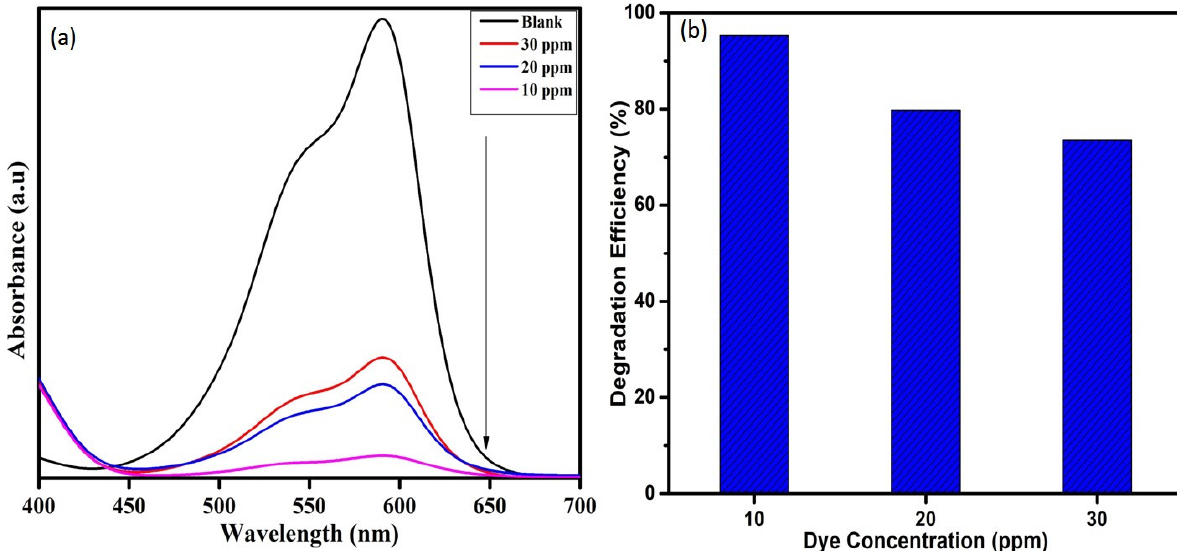
Figure 9. ( a ) UV-Visible absorption spectra and ( b ) Degradation efficiency of WO 3 nanoparticles on varying CV dye concentration